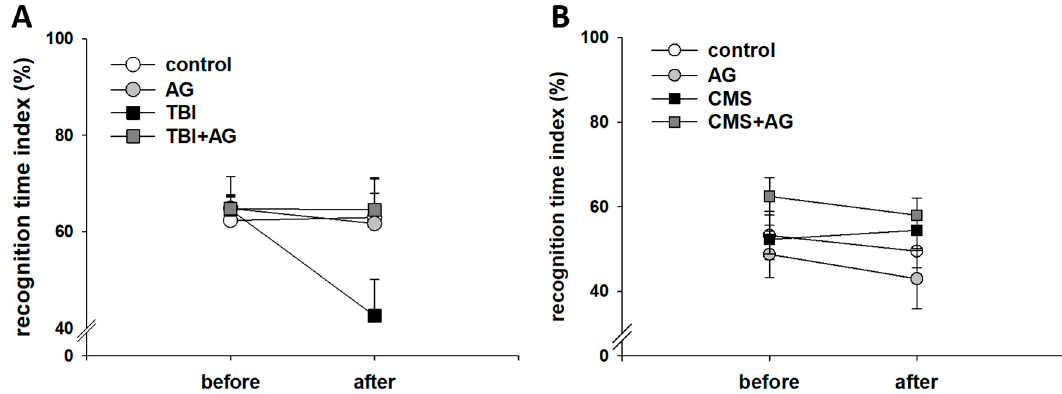
Figure 3. Object recognition memory by AG in the TBI and CMS mice as measured by the recognition time index in the novel object test. ( A ) TBI model. There were before–after (within) effects [F(1,28)